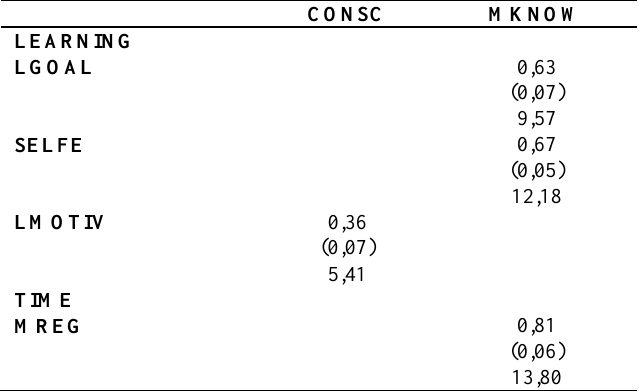
Table 7: Completely standardised gamma